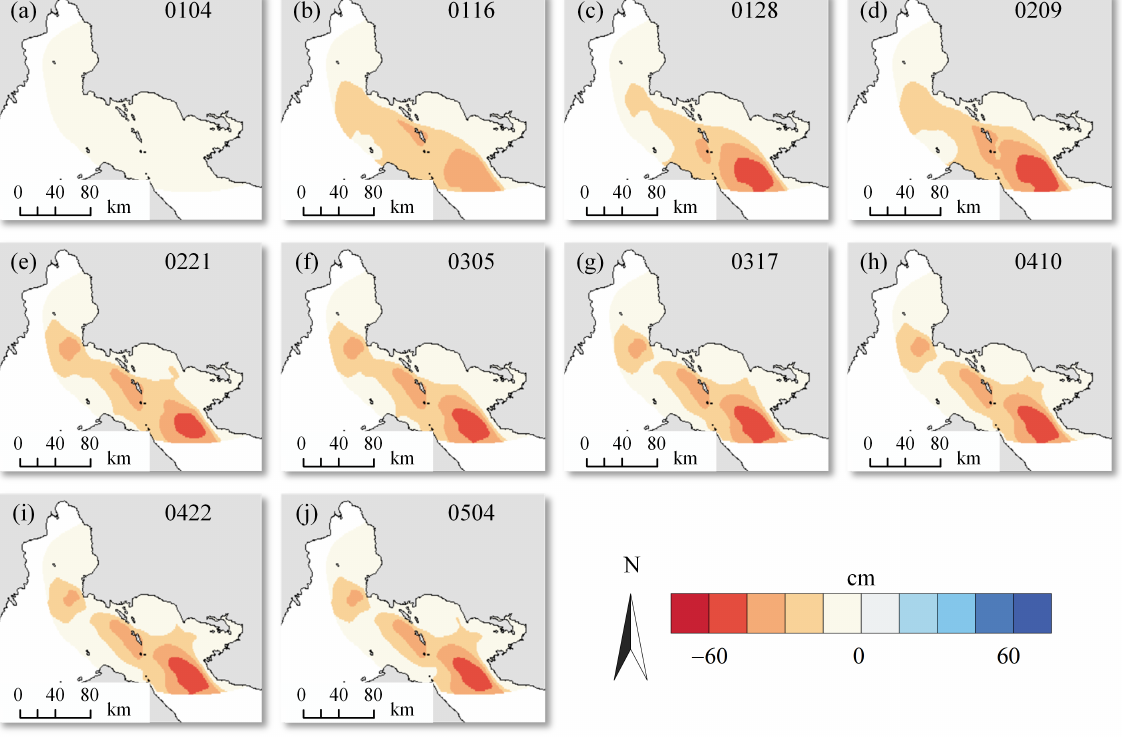
Figure A4. Time-series LOS deformation retrieved from the 2019 ascending images: the top-right number of subfigures ( a – j ) represents the corresponding SAR images acquisition